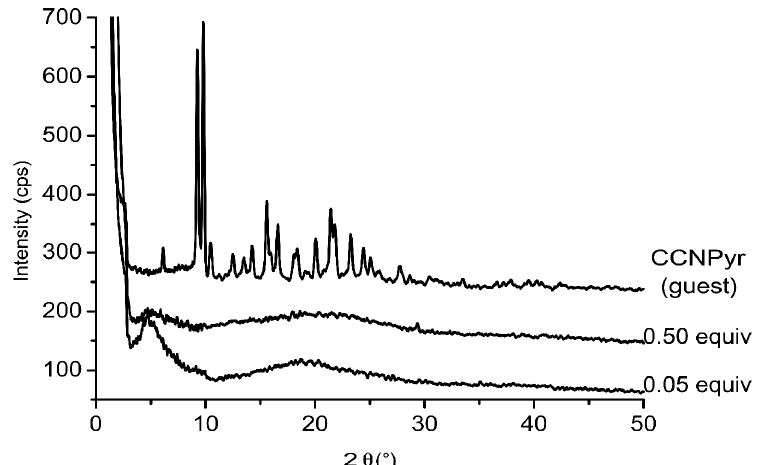
Figure 3. X-Ray diffractograms of guest molecule (CCNPyr) and “host-guest” materials -H/CCNPyr. For sake of clarity, the diffractograms with a CCNPyr loading of 0.5 equiv. Copo C 6 and guest molecule (CCNPyr) were shifted of + 50 cps and + 200 cps respectively. X-Ray diffractograms of other loadings are presented in Supplementary information, Figure